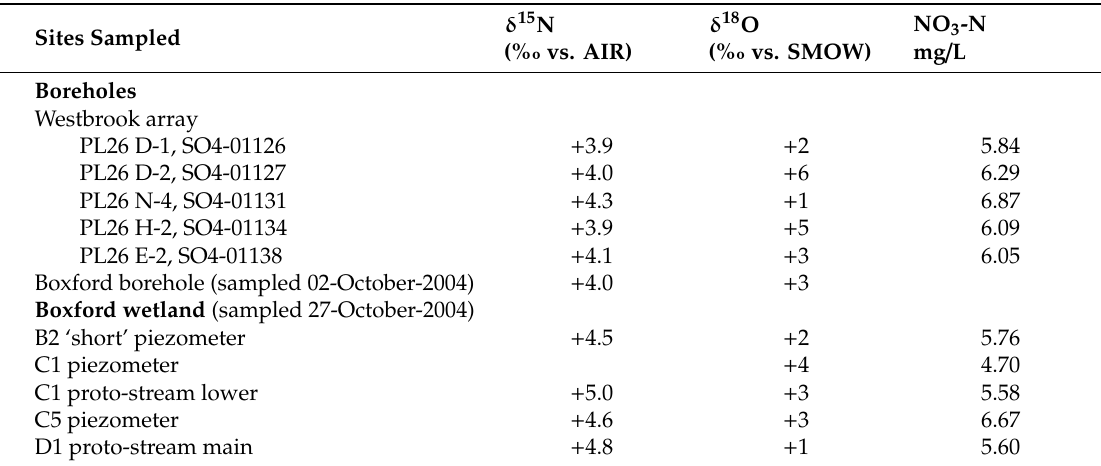
Table 2. 15 N / 14 N and 18 O / 16 O composition of nitrate in water samples. Boxford borehole is marked X on Figure 2. The Westbrook array is 300 m upstream from piezometer A5 on Figure